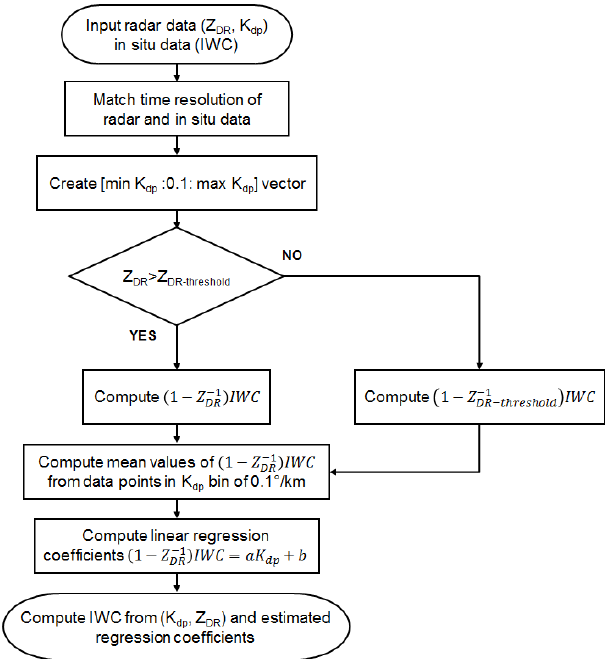
Figure 1. Flow chart of IWC retrieval using (K dp ,Z DR ) and in situ data. In this paper, Z DR-threshold = 1 .